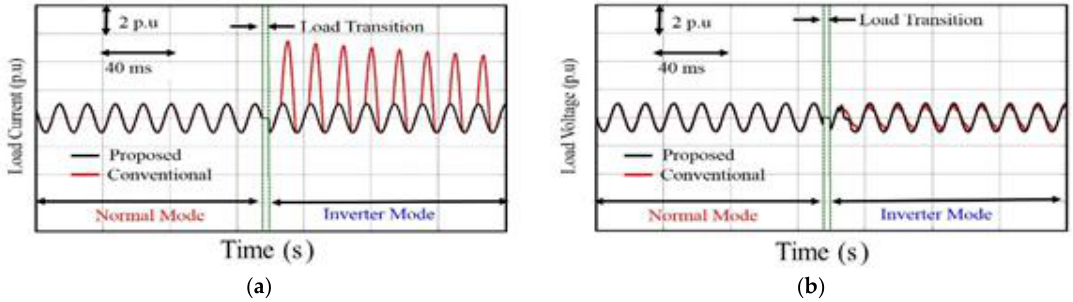
Figure 21. ( a ) Load current; and ( b ) load voltage for the conventional and proposed single-phase offline UPS topologies when the inverter voltage is injected at 270°.